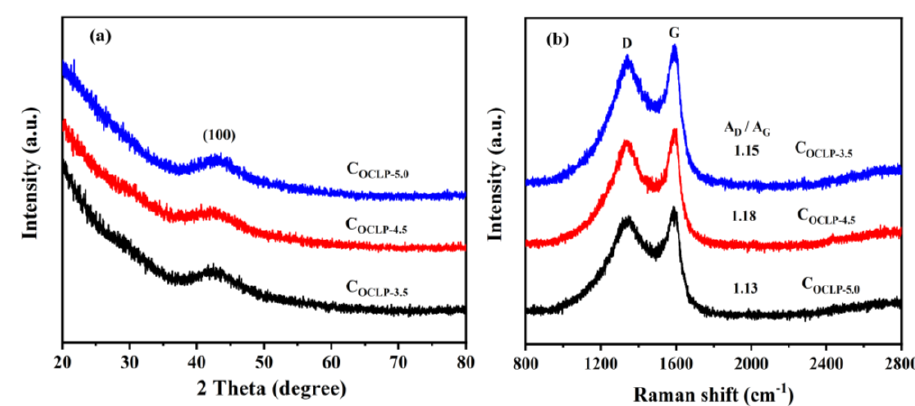
Figure 3. ( a ) XRD patterns of the C OCLPs and ( b ) Raman spectra of the C OCLPs . The surface morphologies of C OCLP-3.5 , C OCLP-4.5 , and C OCLP-5.0 were characterized using